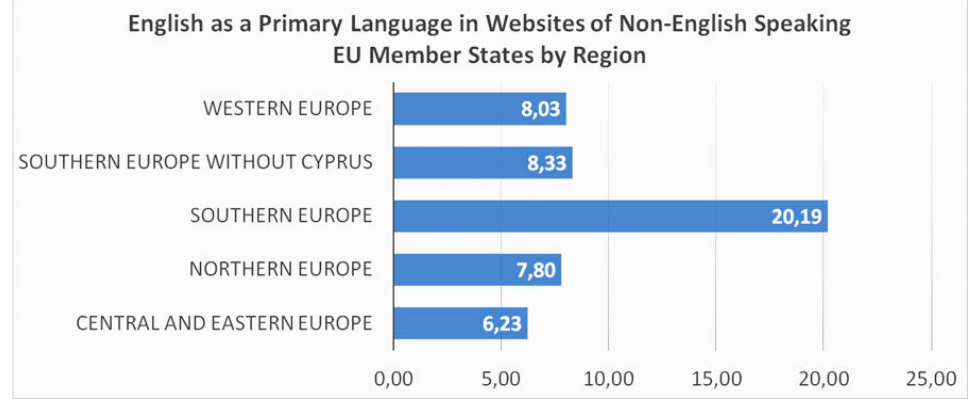
Figure 13. English as a Primary Language in Websites of Non-English speaking EU Member States by Region.